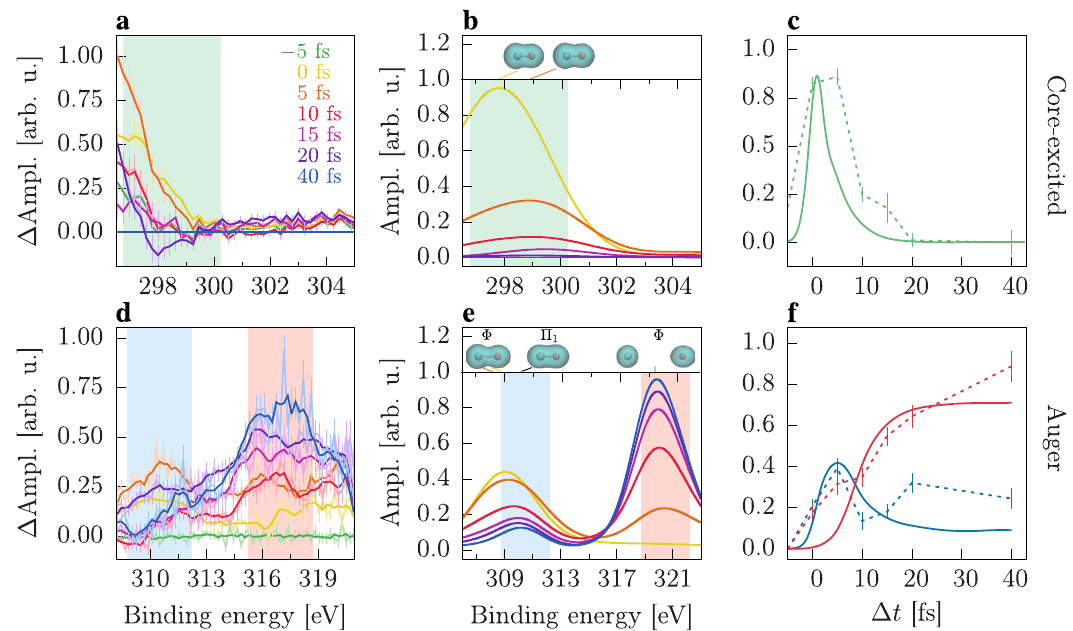
Fig. 2 | Time-dependent XPS spectra and transient signals of core-excited and Auger states. Panels a and d show the measured time-resolved XPS spectra. The corresponding calculated XPS spectra are displayed in panels b and e . The experimental XPS spectrum of the core-excited state shown in panel a is obtained by subtracting the signal at 40fs and Δ Ampl. denotes the resulting difference signal. In panel d Δ Ampl. indicates the spectral amplitude after subtraction of the negative time delay signal. The initial time coincides with the center of the pump